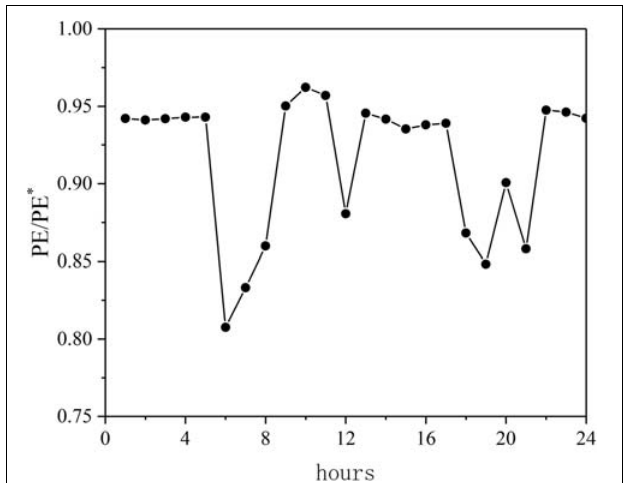
FIGURE 11 | Typical hourly energy consumption ratio in